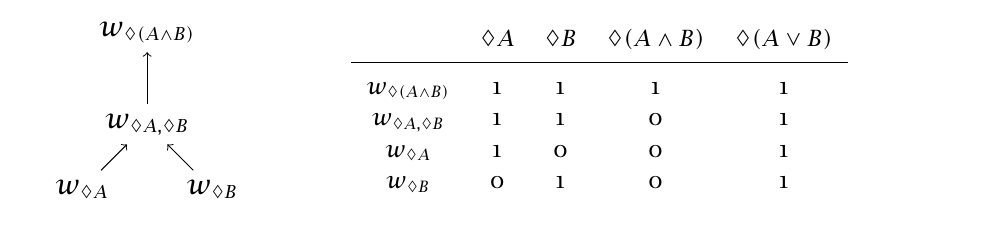
Figure 3 Ordering on worlds for base-level free choice implicature depending on the given set of alternatives. This property also matters